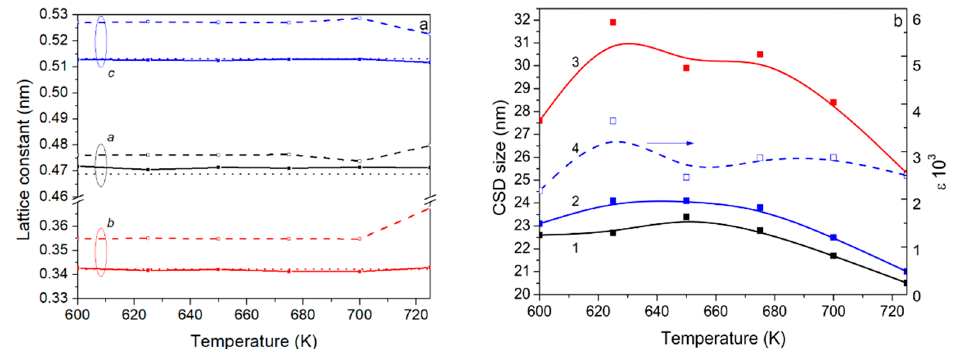
Figure 2. ( a ) Dependence of the lattice constant of the CuO films on the substrate temperature: solid lines correspond to calculation results, dashed-UnitCell software, dotted-reference data; ( b ) effect of the substrate temperature on (4) microstrain level and CSD obtained using (1) Gauss and (3) Cauchi approximation and (2) from threefold convolution.